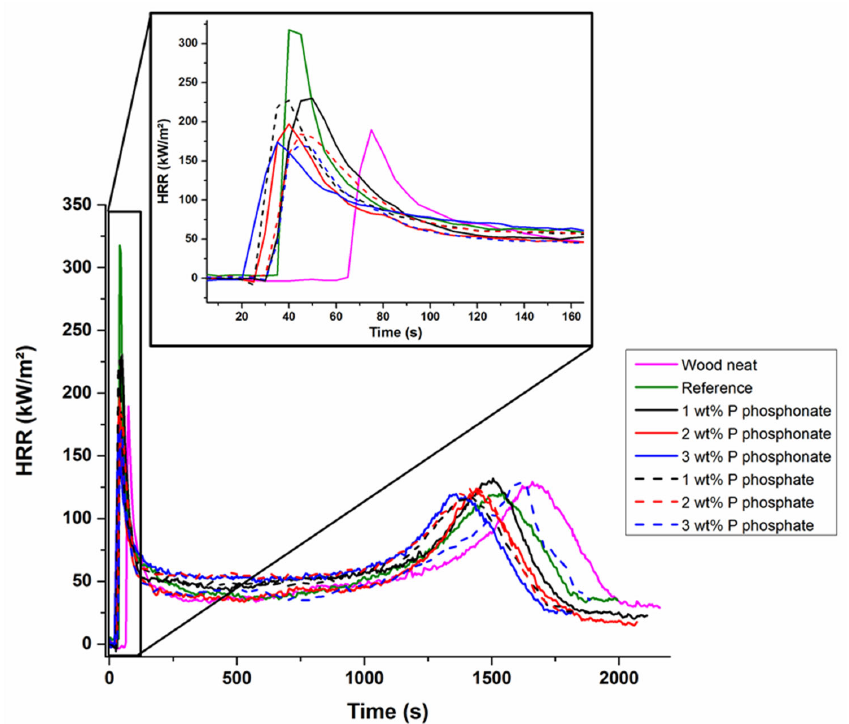
Figure 6. Curves of cone calorimeter tests for wood, reference alkyd resin and phosphorylated car ‐ danol modified alkyd resins. Table 5. Cone calorimeter analyses of phosphorylated cardanol reactive diluent alkyd resins.